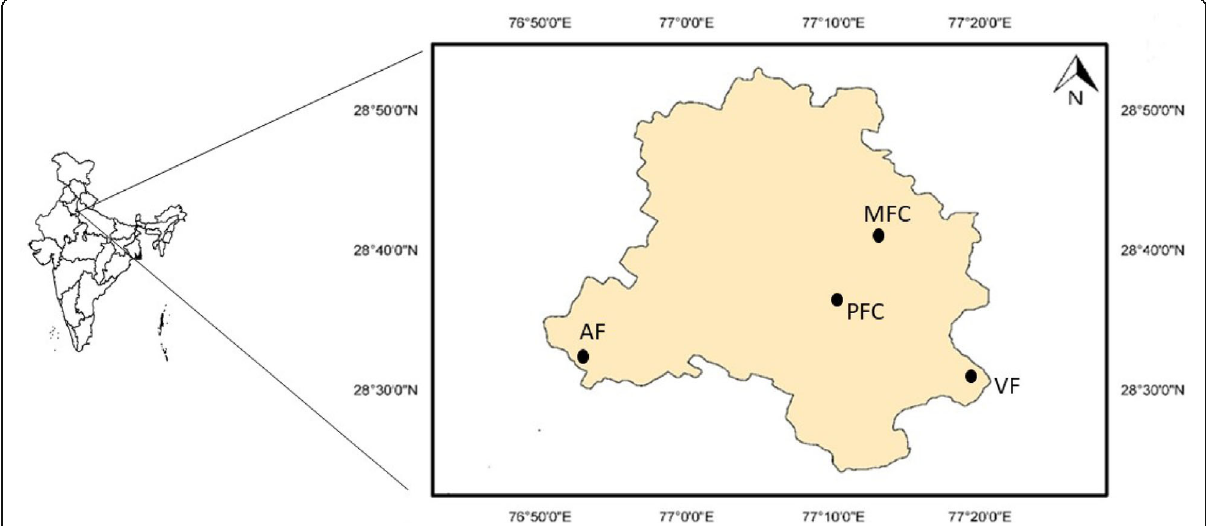
Fig. 1 Map of the study area (Delhi) showing the land use sites. PFC Prosopis juliflora forest cover, MFC mixed forest cover, AF agriculture field and VF vegetable